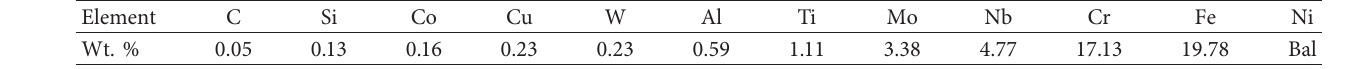
Table 1: The chemical composition of IN718 used for fabrication.